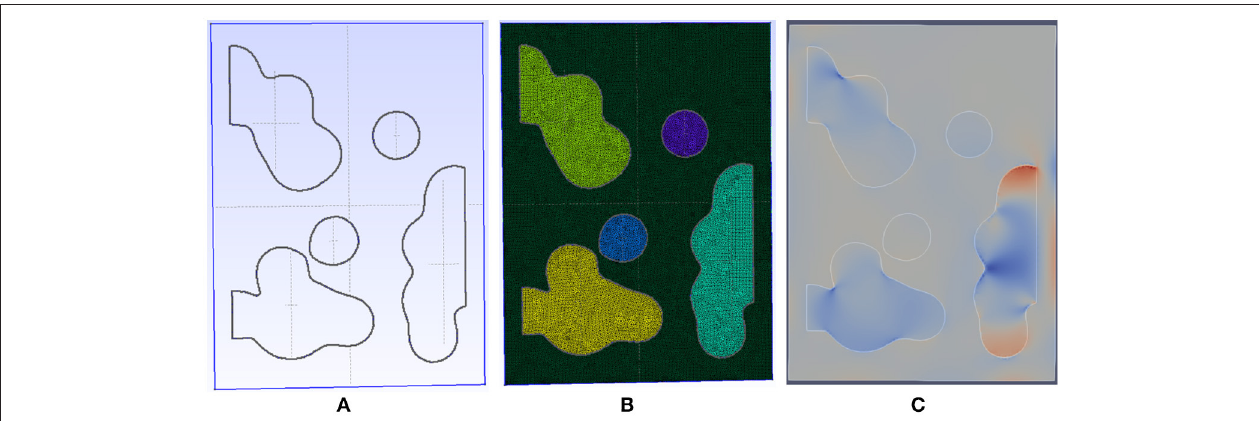
FIGURE 4 | Detail of the meshing process for a patch with initial emphysema formation. (A) The geometry is automatically generated and meshed by gmsh using our code taking into account Agent Based Model. (B) The resulting mesh has an adaptive size to ensure fast convergence and is able to capture complex shape for the destroyed tissue. (C) The generated mesh is then connected to our FEM solver and simulated until convergence is reached. In this image, the displacement field is